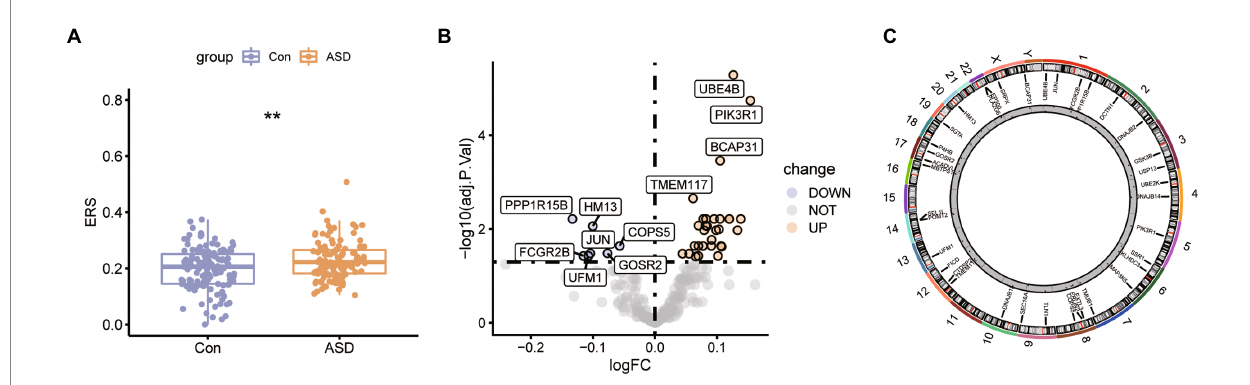
FIGURE 1 The expression pattern of the ER stress regulators in ASD. (A) Box plot for ER stress score between control ASD group. * p < 0.05, ** p < 0.01. (B) The volcano plot of the 256 ER stress regulators in control and ASD groups. (C) Chromosomal positions of the differential expressed ER stress regulators.